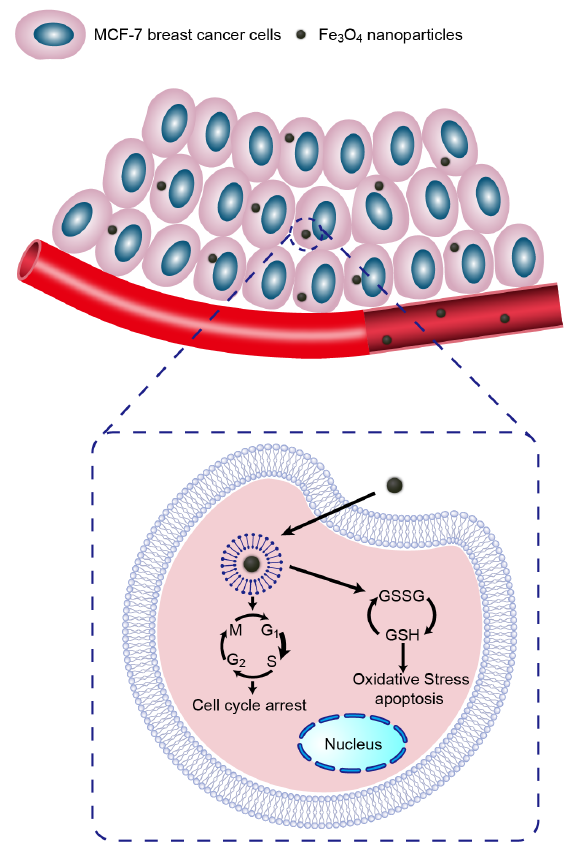
Figure 1: Schematic diagram of interaction of Fe 3 O 4 NPs and MCF-7 breast cancer